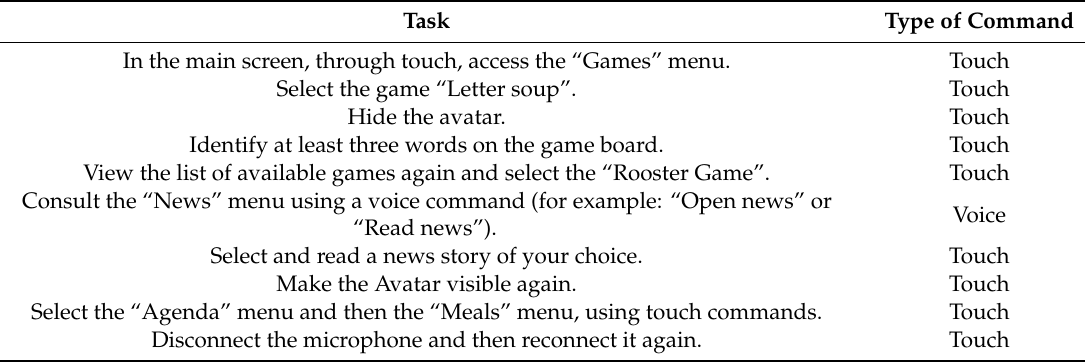
Table 1. Type of command for each task. Task Type of Command In the main screen, through touch, access the “Games”